Question: Based on the figure, does the quantity rise or fall?
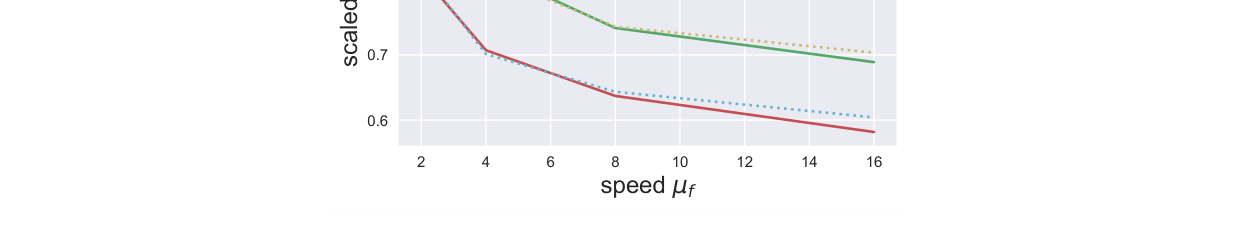
Answer: increasing